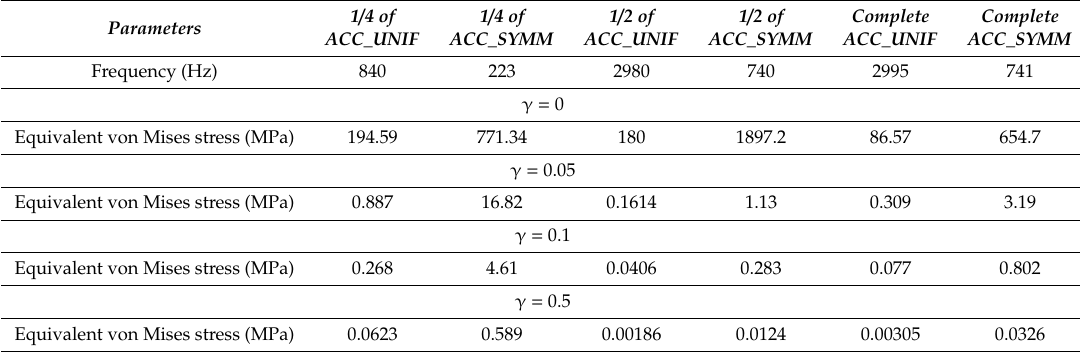
Figure 6. Harmonic response of devices with damping factor ( γ ): ( a ) 1 / 4 of ACC_SYMM and 1 / 4 of ACC_UNIF. ( b ) 1 / 2 of ACC_SYMM and 1 / 2 of ACC_UNIF. ( c ) Complete ACC_SYMM and Complete ACC_UNIF. Table 10. Fundamental parameters at critical harmonic frequency for di ff erent damping factors ( γ ).